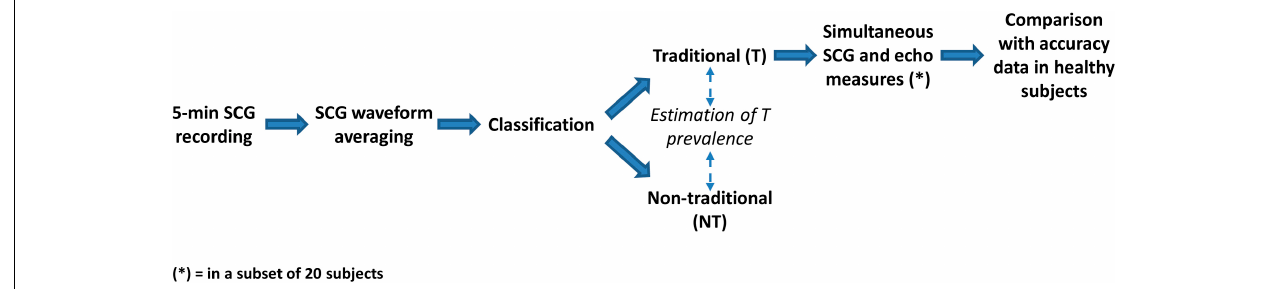
FIGURE 2 | Scheme of the